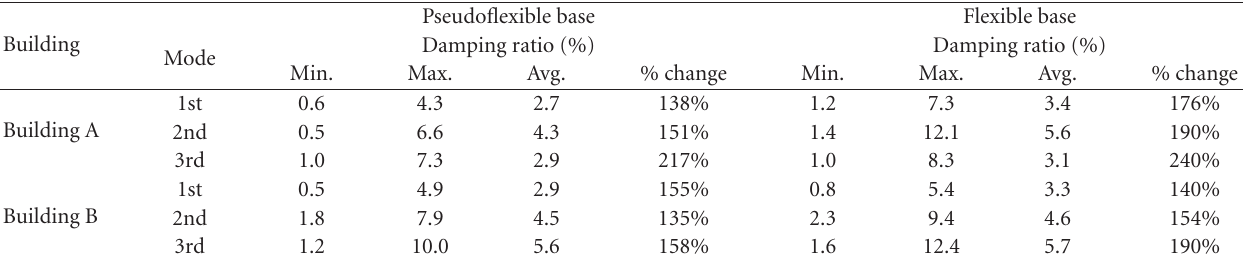
Table 6: Summary of identified damping ratios for buildings A and B for pseudoflexible and flexible base models.